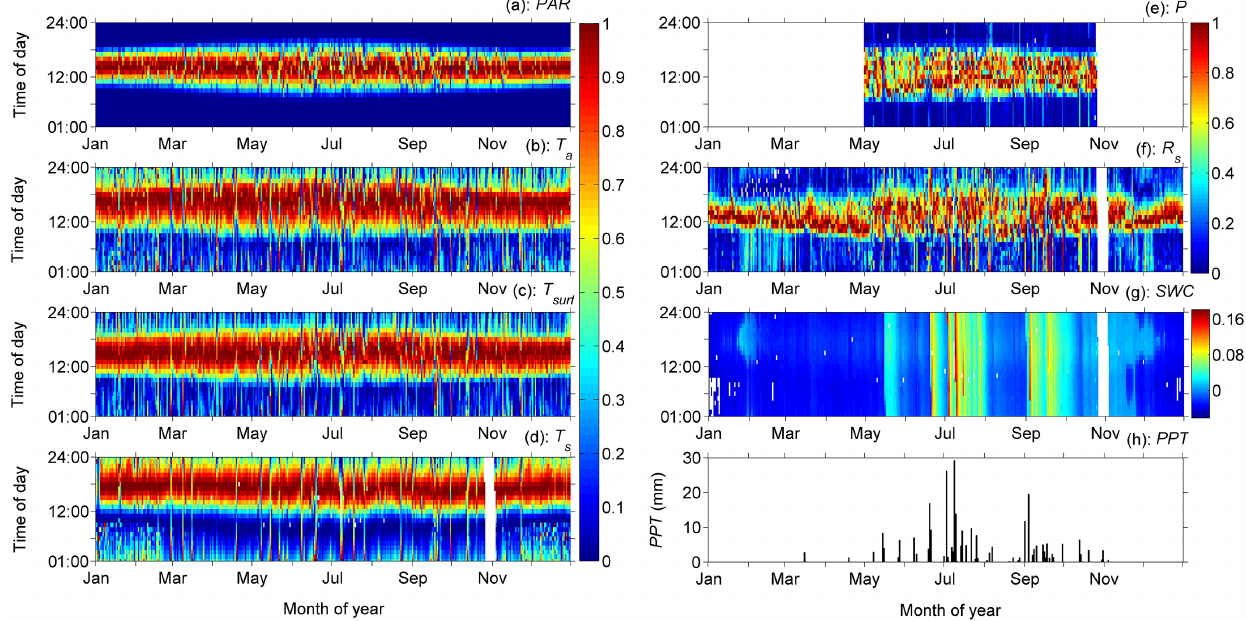
Figure 1. Seasonal variation in incident photosynthetically active radiation (PAR), temperature (i.e., air ( T a ) , soil-surface ( T surf ) , and soil temperatures ( T s ) ), photosynthesis ( P) , and soil respiration ( R s ) at an Artemisia ordosica -dominated site, and seasonal variation in soil water content (SWC) and precipitation (PPT) for 2013. Hourly PAR, T a , T surf , T s , R s , and P are normalized against all values for each day. Each hourly value ( y axis) for each day ( x axis) is shown as a value of 1 through 0; 1 denotes the peak value for a given day and 0 is the daily minimum value. Table 1. Analysis of mean monthly diel cycles of soil respiration ( R s ) , air temperature ( T a ) , soil-surface temperature ( T surf ) , soil temperature at a 10cm depth ( T s ) , and photosynthesis ( P) in a dominant desert-shrub ecosystem, including correlation coefficients and time lag times